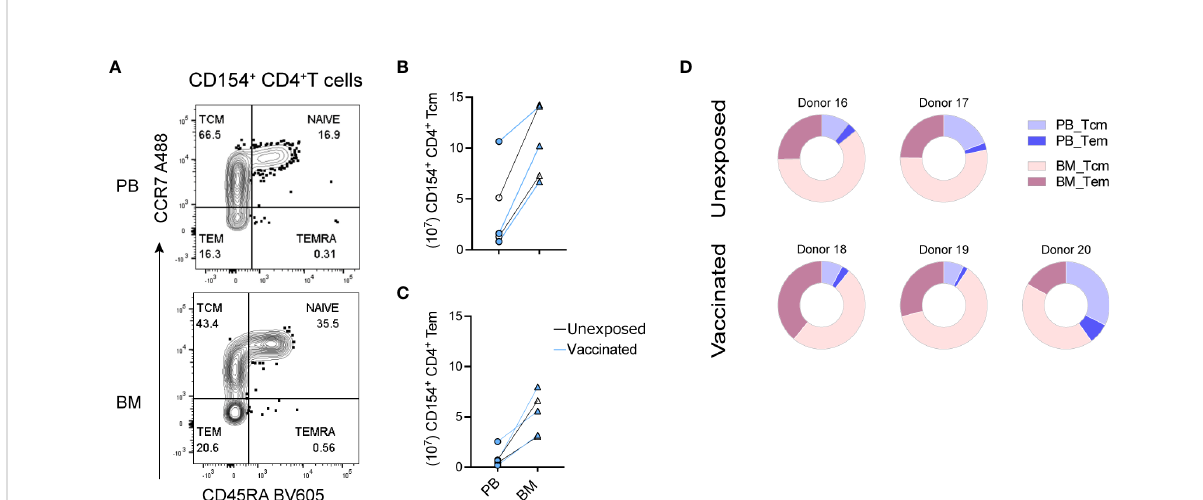
FIGURE 2 Central memory SARS-CoV-2-reactive memory CD4 + T cells of bone marrow. Paired PBMCs and BMMCs from two naïve and three vaccinated donors stimulated with S/M/N of SARS-CoV-2 and analyzed for SARS-CoV-2-reactive CD154 + CD4 + T cells. (A) Representative fl ow cytometric plots showing their counter expressions for CD45RA and CCR7 on CD154 + CD4 + T cells (Supplemental Figure 2A). ( B + C ) Estimated absolute numbers of CD45RA - CCR7 + Tcm (B) and CD45RA - CCR7 - Tem (C) types of SARS-CoV-2-reactive CD154 + memory CD4 + T cells of PB and BM, calculated using the frequency (Supplemental Figures 2B, C) of these cells and the estimated numbers of T cells within BM and PB as described in Figure 1. Blue symbols represent data obtained from vaccinated donors. (D) Pie charts showing the proportion of SARS-CoV-2-reactive CD154 + memory CD4 + T cells in the sum of PB and BM as well as their distribution to Tcm and Tem